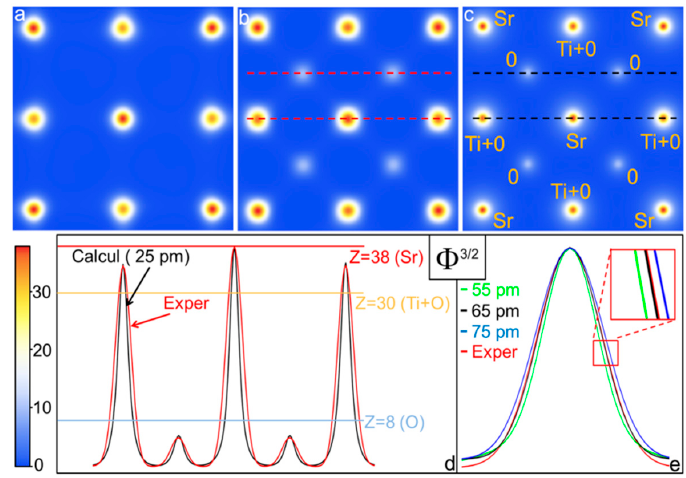
Figure 3. Deconvolution of the projected atomic potential auto-correlation function C( r ): ( a ) C( r ) atomic projected potential obtained from raw experimental nano-diffraction data; ( b ) C( r ) atomic projected potential obtained from rescaled nano-diffraction data; ( c ) SrTiO 3 calculated projected atomic potential in [100] zone-axis; ( d ) red curve: sum of the two scans highlighted with the red dashed lines in Figure 3b; black curve: sum of the two scans highlighted with the black dashed lines in Figure 3c. In Figure 3d the experimental and calculated potentials Φ have been normalized to 1, plotted at a power of 3/2 and rescaled to have a maximum equal to Z = 38 (Sr); ( e ) zoom of the Sr peak to compare its experimental width (red curve), with projected potential values simulated at different spatial resolutions.